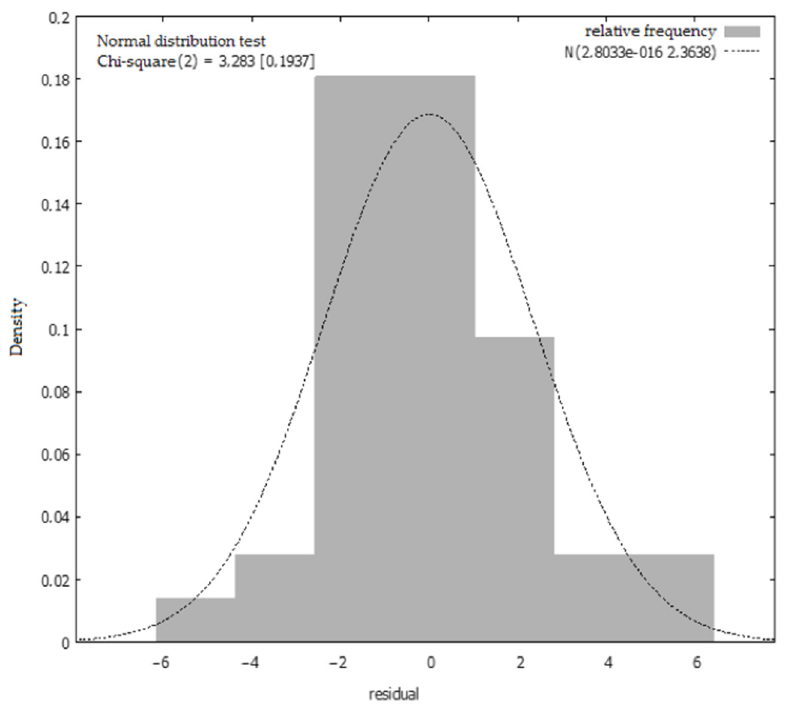
Figure 2. Histogram of regression residuals and frequency distributions.